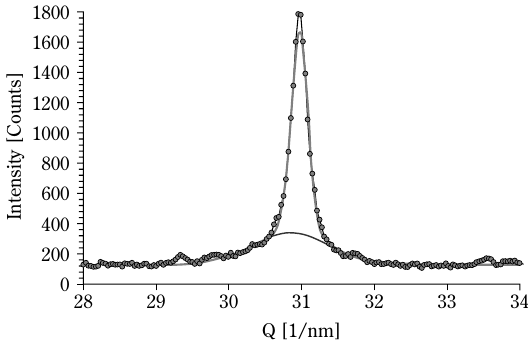
Fig. 4 ND of the (110) Fe reflection. Note the presence of the two Gaussian fits under the peak.